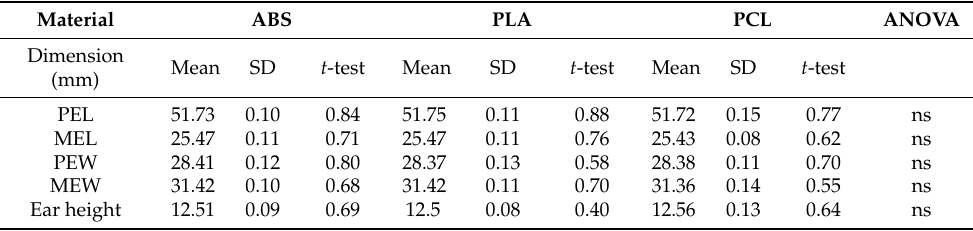
Table 4. Descriptive statistics for measurements for the dimensions of the solid auricular constructs in mm ( n = 5; the significance threshold was set as p < 0.05, p -value for all statistical test were ns = not